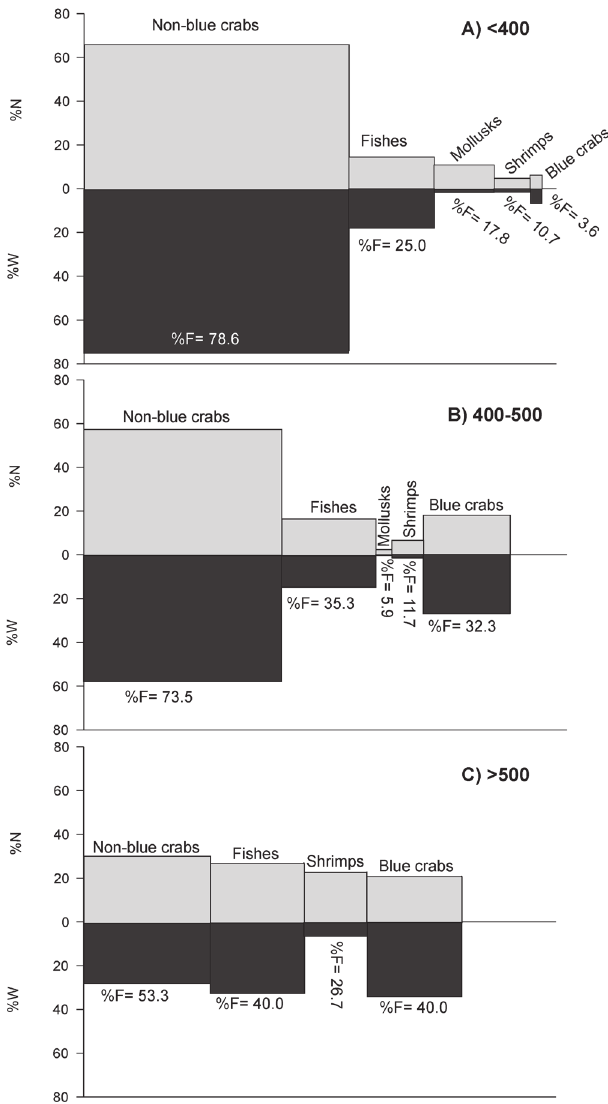
Fig. 2. Components (%N, %W, %F) of the Index of Relative Importance (%IRI) for each of the five major categories of food found in the stomach content of three size classes ( A : <400 mm TL; B : 400-500 mm TL; C : >500 mm TL) of the dusky grouper Mycteroperca marginata . The number of individuals analyzed in each size class is 29, 34 and 15, respectively.